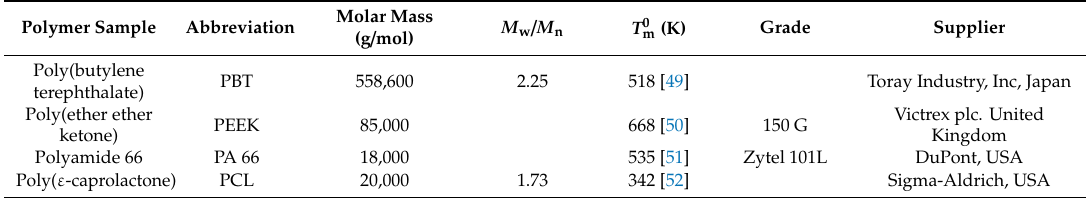
Table 1. Details of samples used for AFM-FSC